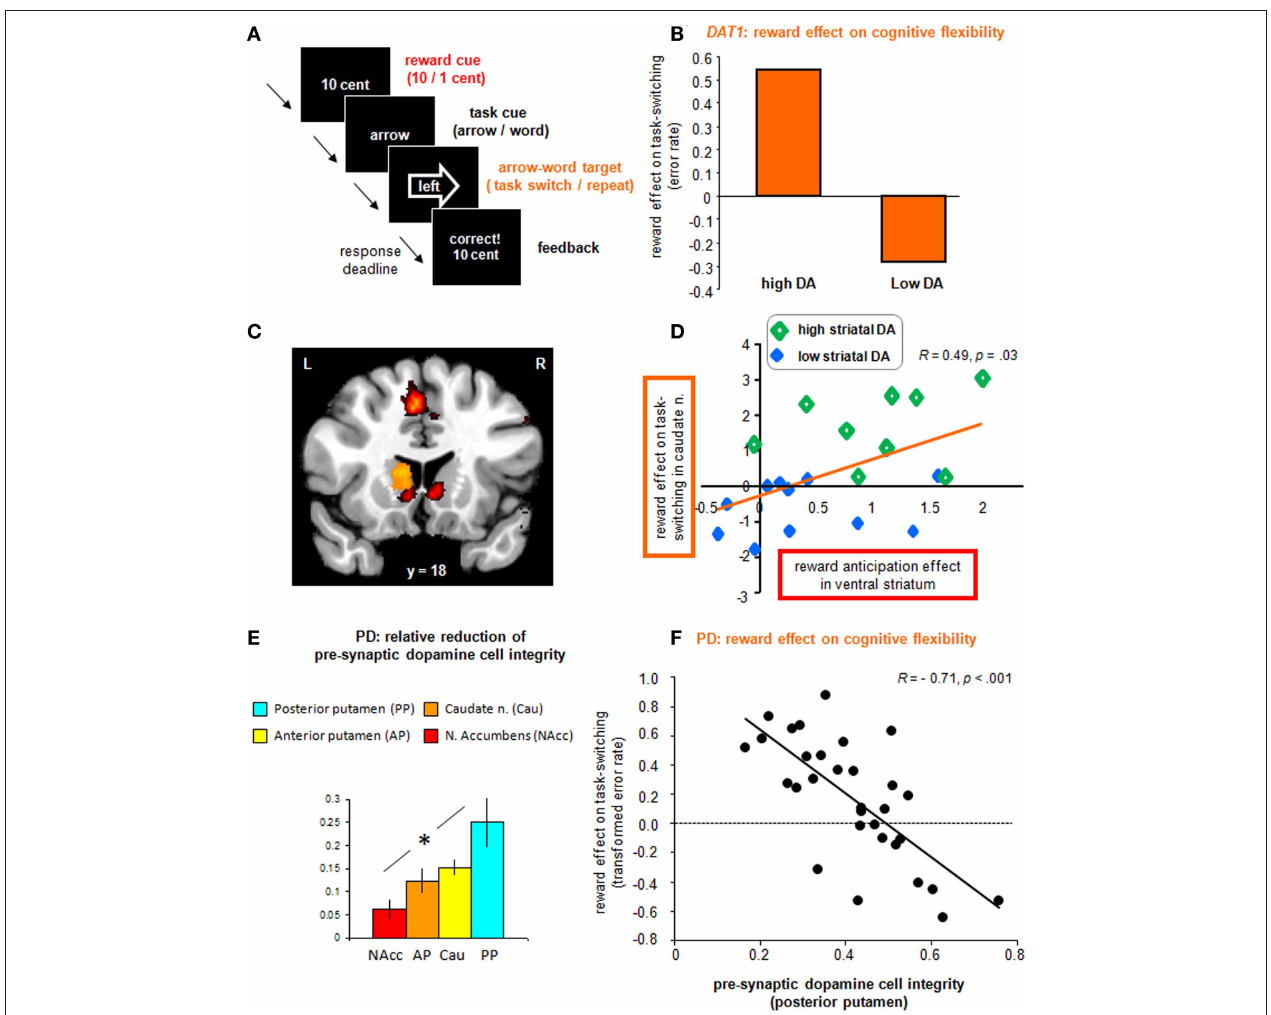
Figure 2 | experimental evidence for the beneficial effect of motivation on cognitive flexibility in humans. (A) The rewarded set-shifting paradigm used in our studies to investigate the motivation–cognition interface. (B) In our genetic imaging study (Aarts et al., 2010), participants with genetically determined high striatal dopamine levels benefited more from reward anticipation in terms of set-shifting than participants with low dopamine levels. (C) In our genetic imaging study (Aarts et al., 2010), reward cues elicited activity in VMS (in red), whereas the dopamine-dependent effect of reward prediction on set shifting was observed in DMS (in yellow). (D) Activity in these striatal sub-regions [see (C) ] was positively correlated, with high striatal dopamine subjects showing high